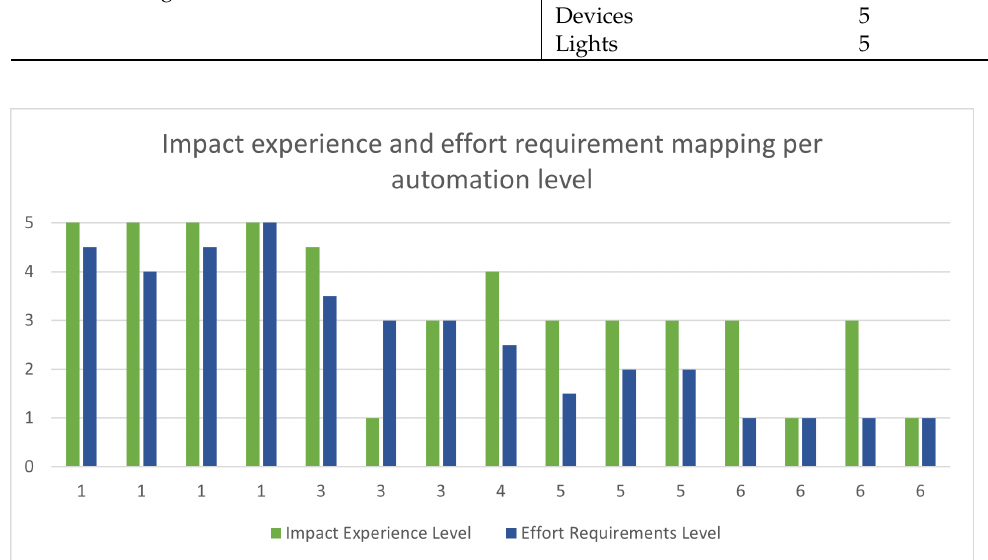
Figure 2. Effort requirement and impact experience per case and automation level.